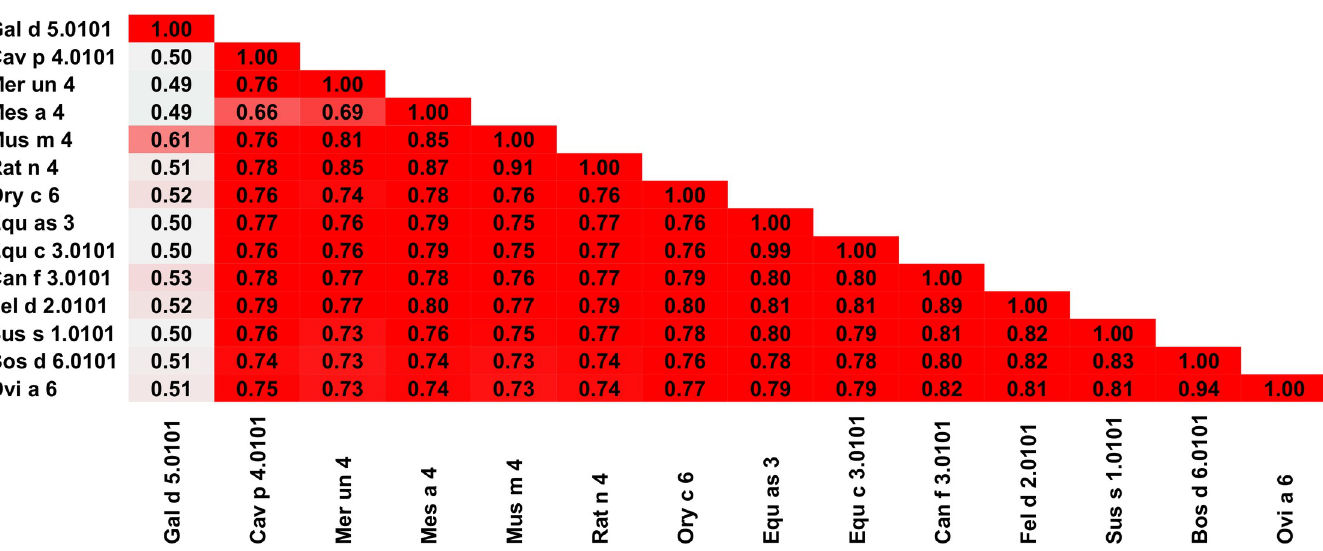
PLOS ONE | https://doi.org/10.1371/journal.pone.0208276 November29,